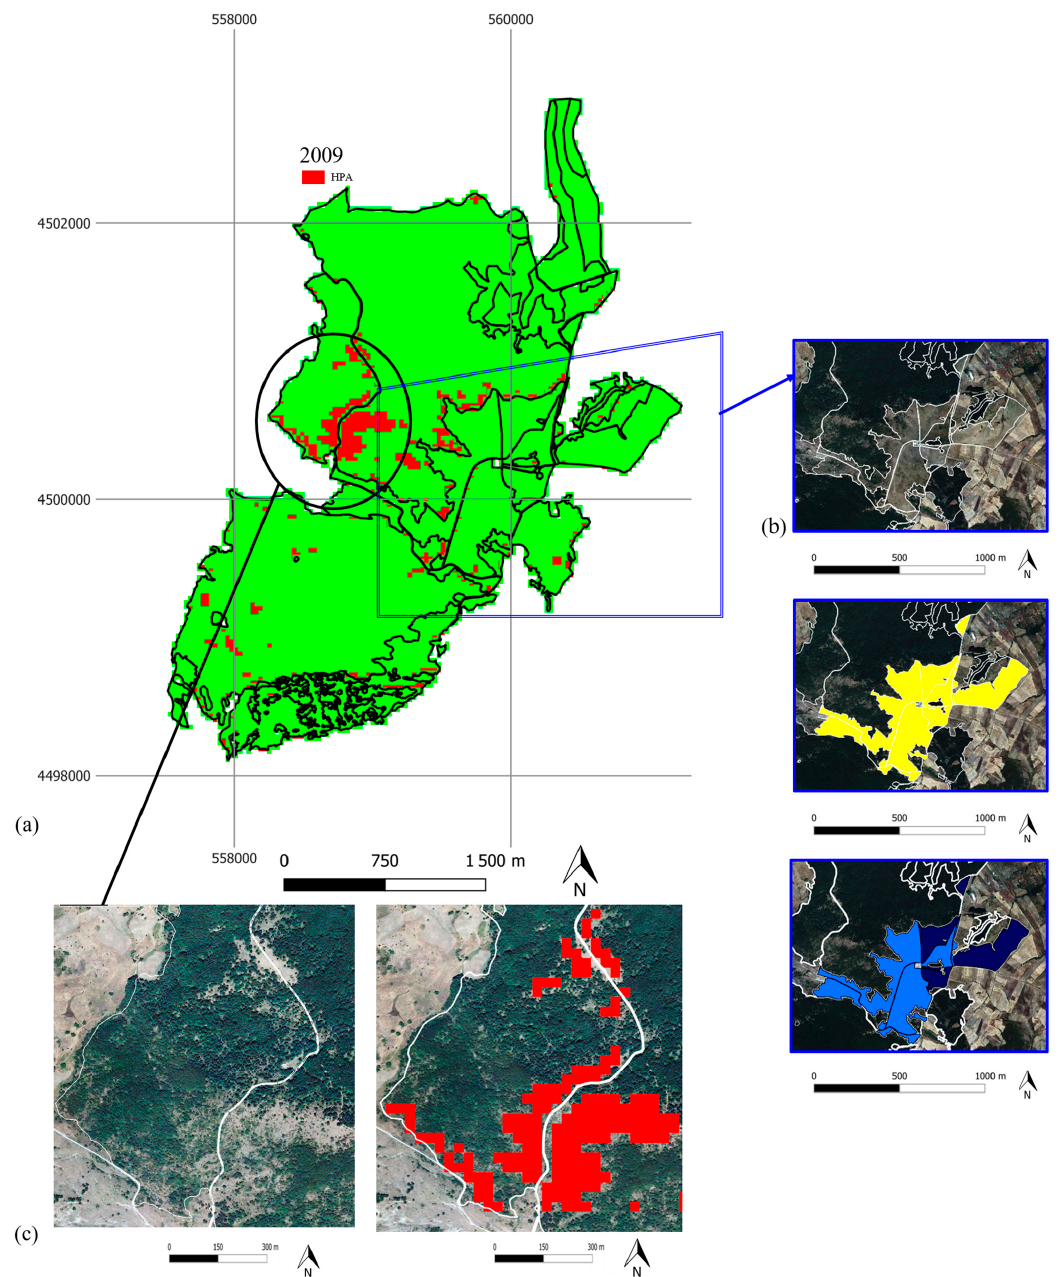
Figure 7. Monti Li Foi SAC: ( a ) Map of relative anomalies (2009); zoom of negative anomalies superimposed on the orthophoto within ( b ) habitat 6210* and 6510 ( Semi-natural dry grasslands and scrubland facies on calcareous substrates—Festuco-Brometalia with important orchid sites and Lowland hay meadows—Alopecurus pratensis, Sanguisorba officinalis ), highlighted in yellow, as examples of good vegetation conditions maintained, in the case of the habitat 6510, by sustainable agricultural practices; ( c ) habitat 9210 ( Apennine beech forests with Taxus and Ilex ) due to overgrazing along with the lack of silvicultural